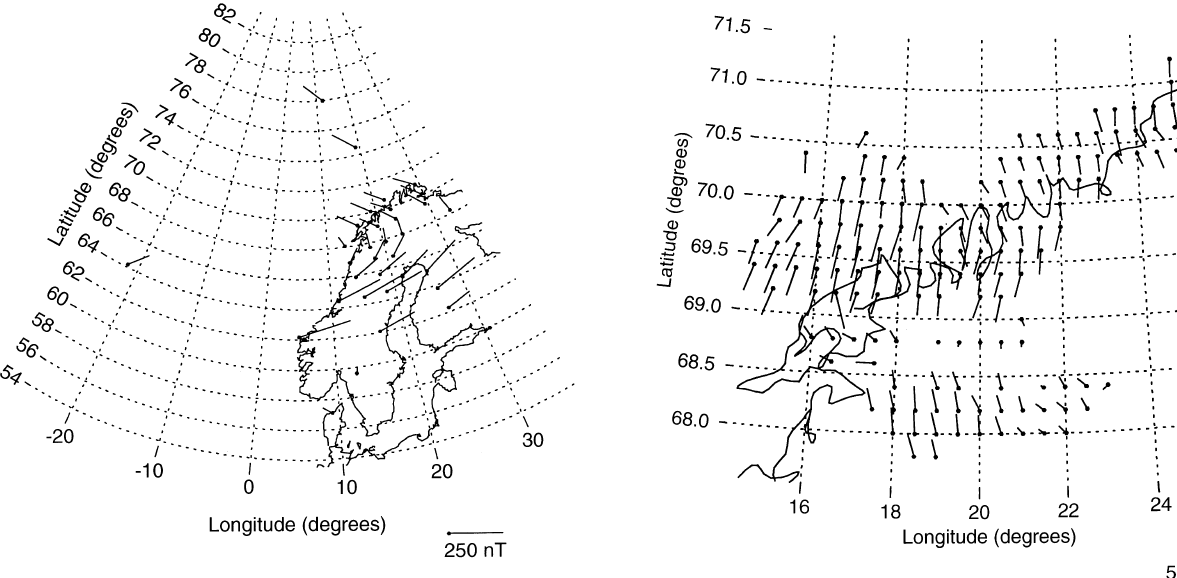
Fig. 3. By 90 (cid:14) clockwise-related horizontal ground magnetic disturbance measurements of SMA and other ground magnetometers for 27 October 1979, 17:39 UT. Latitudes and longitudes are geographic